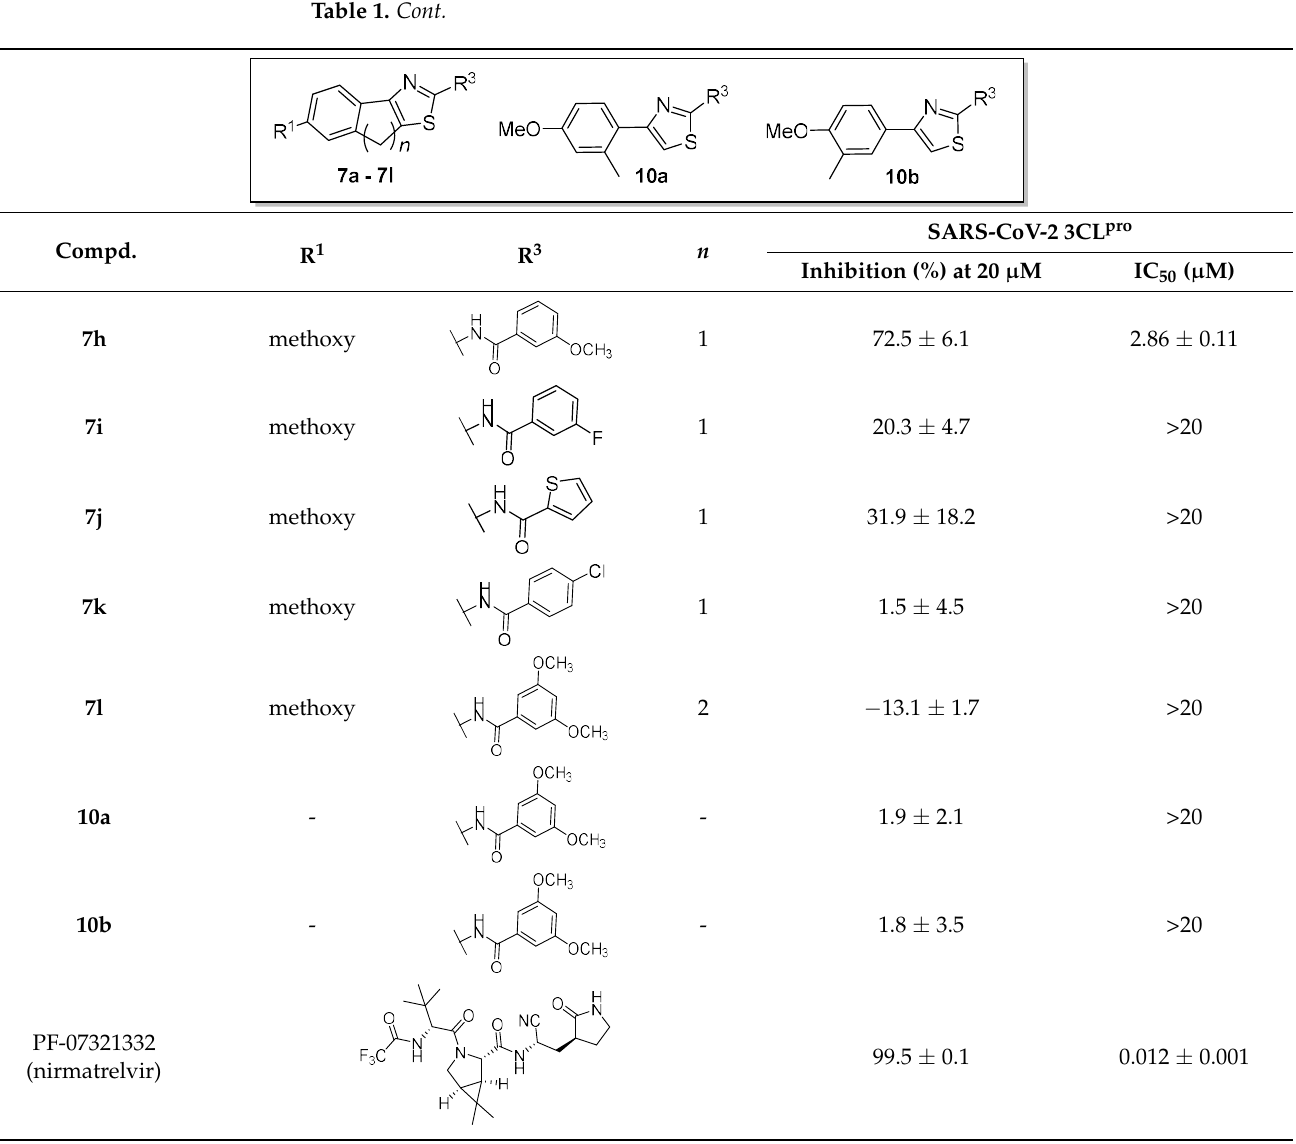
Table 1. Cont. Table 1. Inhibitory activities of target compounds against SARS-CoV-2 3CL pro